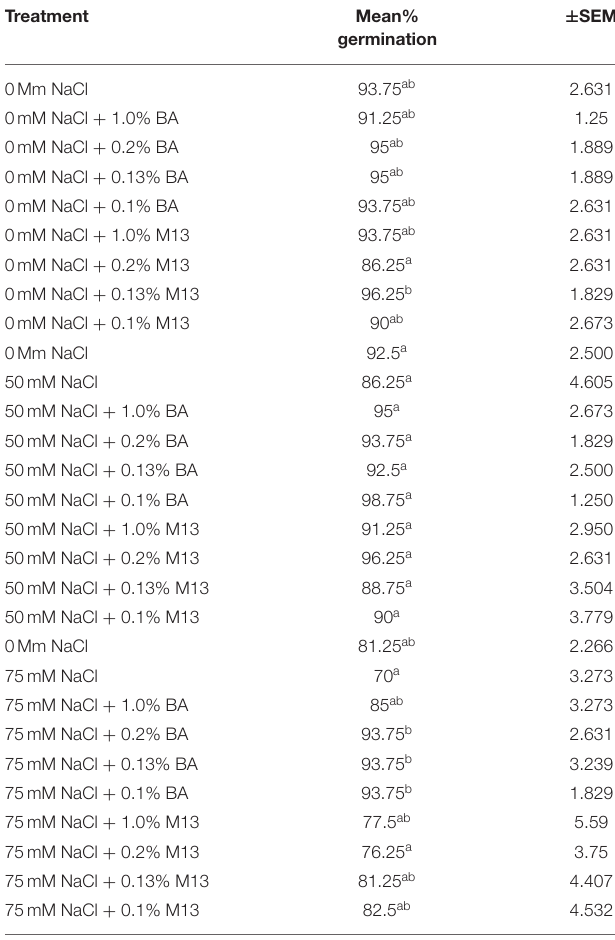
TABLE 6 | Effect of treatment on mean radicle length and mean percentage germination of corn exposed to 0, 50, and 75mM NaCl, for 72h. Treatment